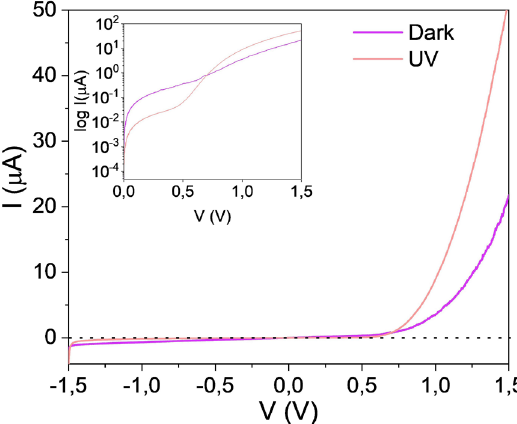
(60min)/ZnO/glass Figure 6. Current-voltage measurements of SnO 2 samples in the dark and with UV illumination, inset below this value the resistance and the capacitance of the material has an average of 2520 Ω and 1.12 nF, respectively. The inset to the graph shows the equivalent circuit of ZnO/SnO films. 2